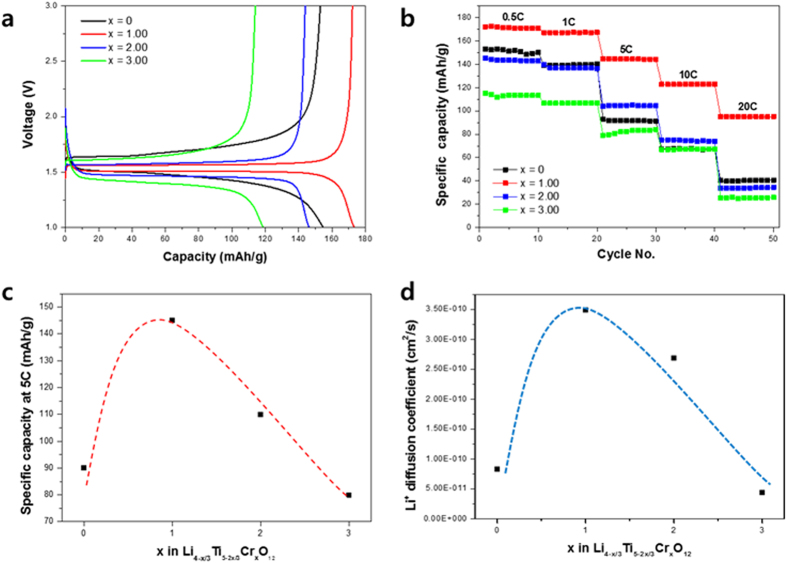
(a) Charge–discharge curves at 0.5 C (b) rate capability (c) specific capacity at 5 C, and (d) Li+ diffusivity of Li4−x/3Ti5−2x/3CrxO12 (x = 0, 1, 2, 3).